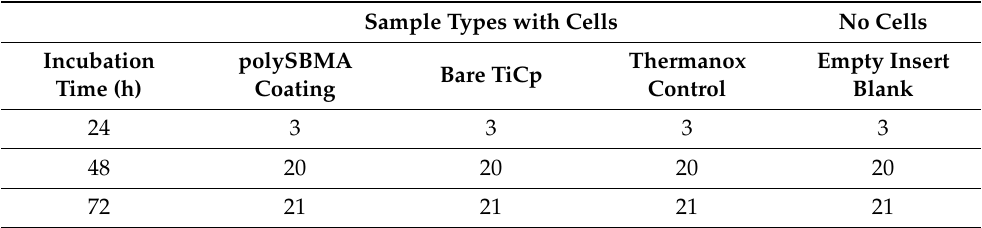
Table 1. Number of samples used in XTT